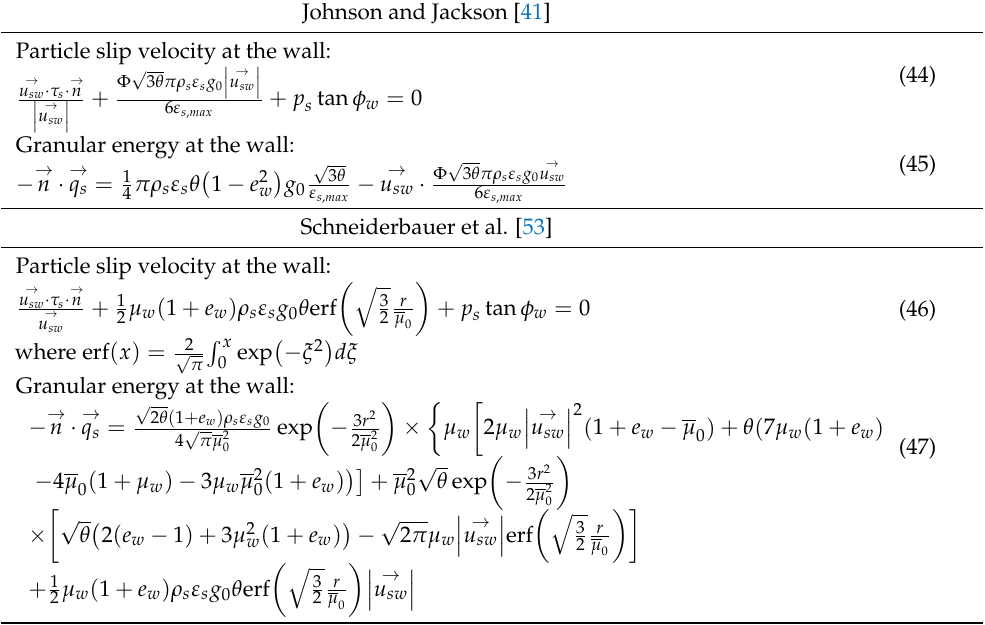
Table 11. Models of wall boundary condition. Johnson and Jackson